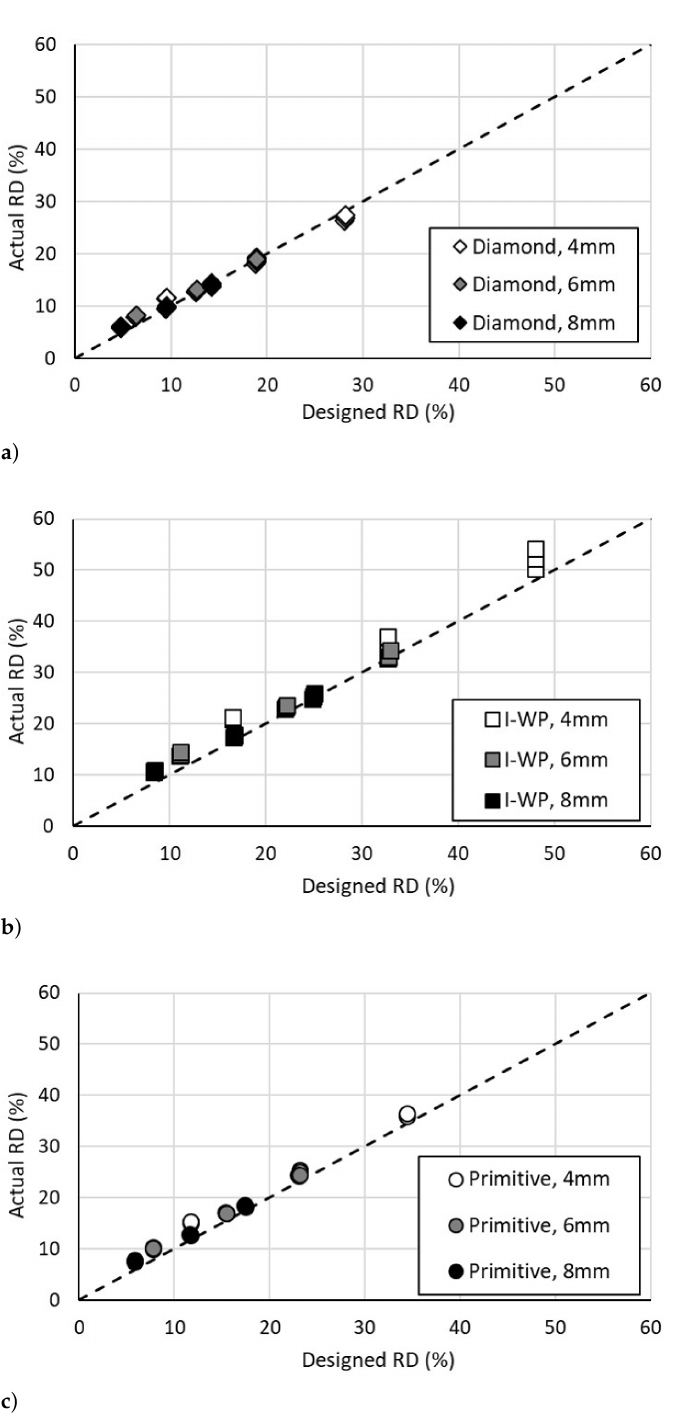
Figure 4. Designed versus actual relative density of: ( a ) Diamond lattice design, ( b ) I-WP lattice design, ( c ) Primitive lattice